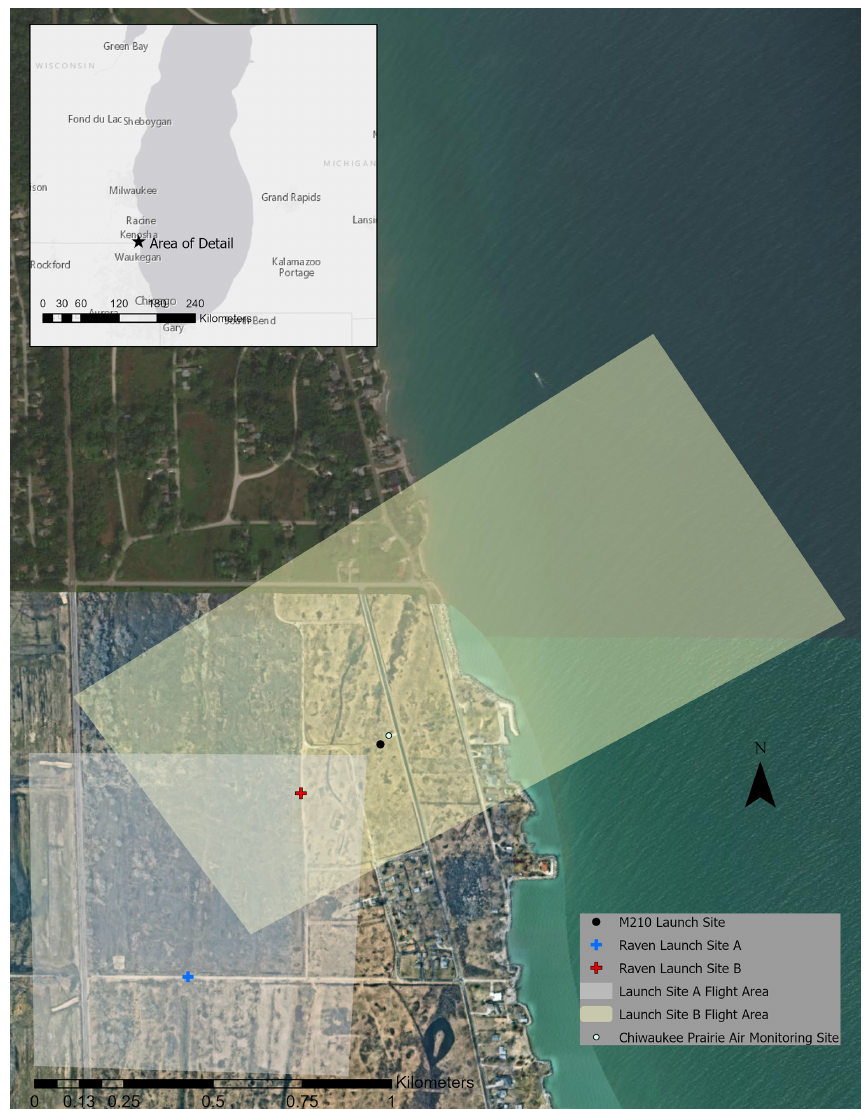
Figure 4. Research site map including Chiwaukee Prairie air monitor and locations for launch sites for M210 and RAAVEN. Map created using Esri ArcPro version 2.52 using ArcPro basemap